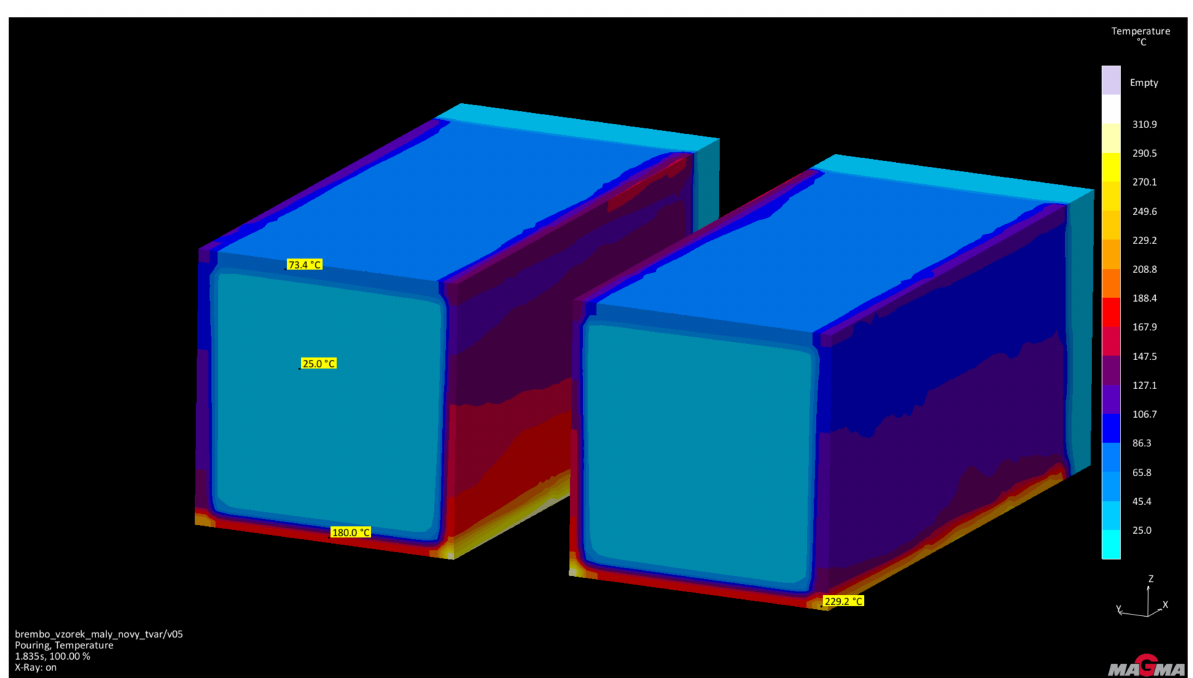
Figure 5. Temperatures of testing cores after